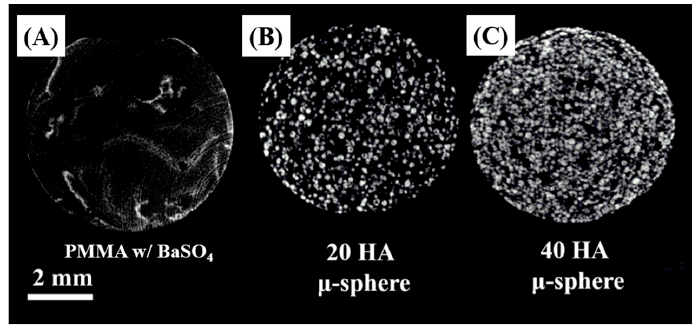
Figure 9. Representative µ-CT images captured from ( A ) PMMA containing barium sulfate; PMMA/HA composites with various HA contents of ( B ) 20 vol % and ( C ) 40 vol %.